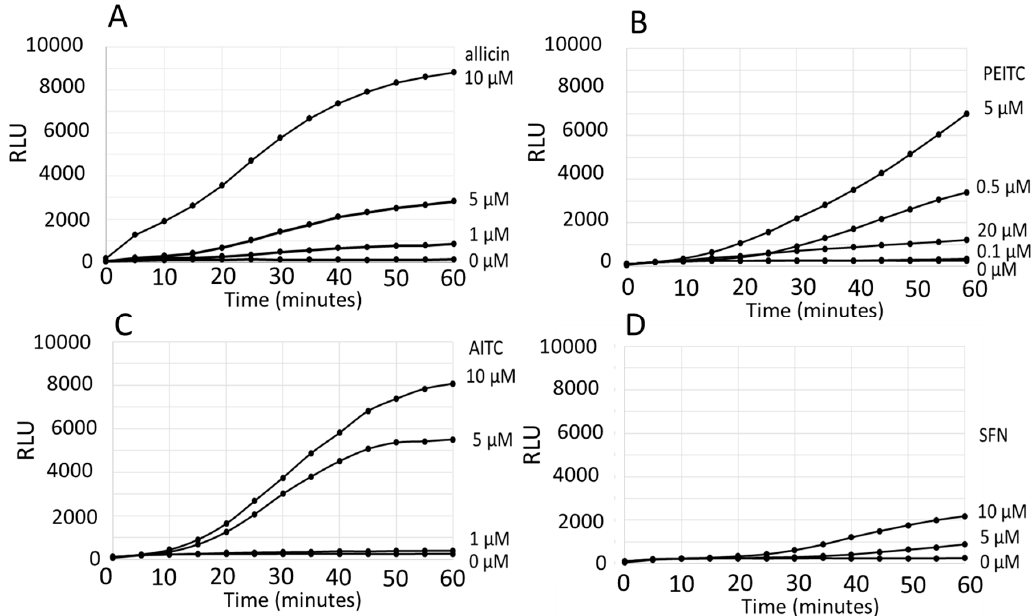
Figure 2. Dynamic response of yeast cells containing the OSI1 ::luciferase reporter to ( A ) allicin, ( B ) phenylethyl isothiocyanate (PEITC), ( C ) allyl isothiocyanate (AITC), ( D ) sulforaphane (SFN). Dose-dependency can be seen, and higher concentrations, which can already potentially damage the cells, show a lower luminescence signal, as can be seen in the example of 20 µM PEITC ( B ). RLU is the abbreviation for Relative Luminescence Units.